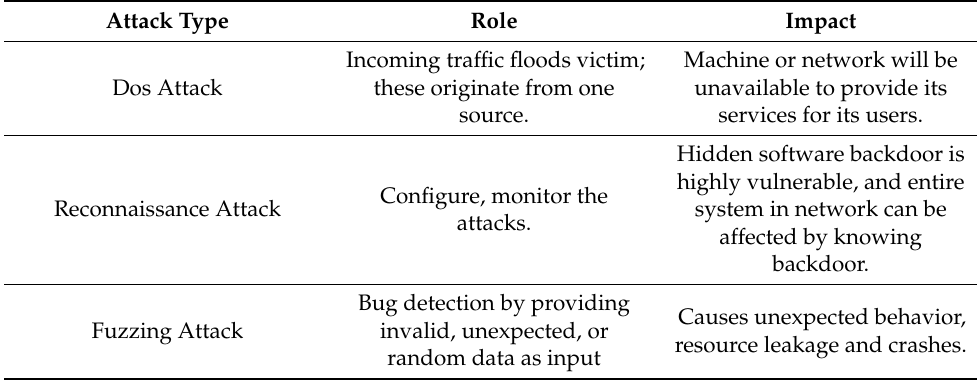
Table 5. Attack types used in the